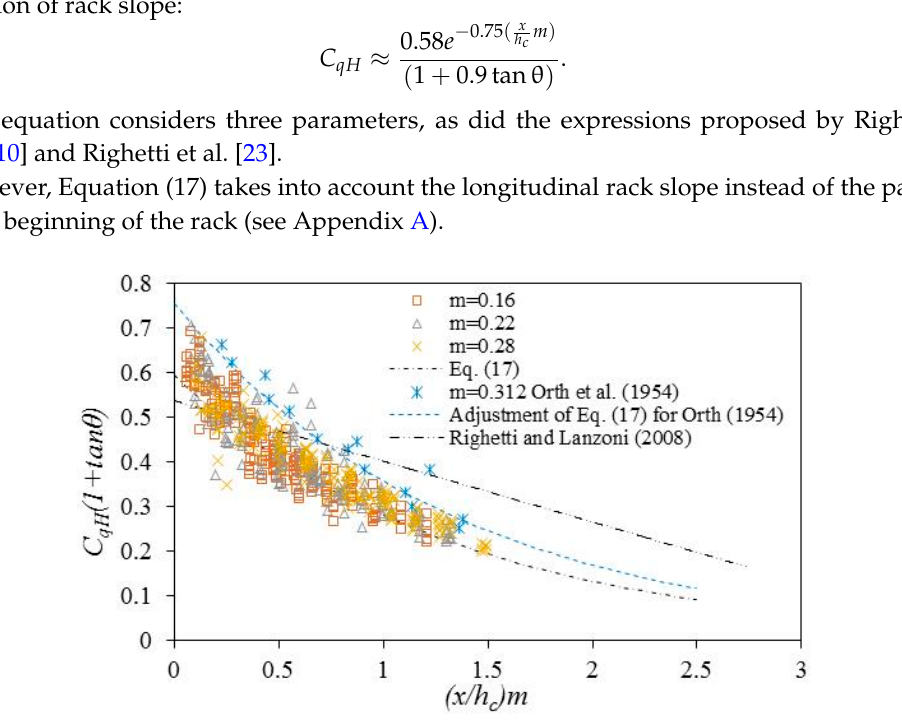
Figure 14. Discharge coefficient, C qH , calculated from Equation (1) for void ratios, m = 0.16, 0.22 and 0.28, and slopes from horizontal to 33%. Exponential adjustment for T ‐ shaped bars and for measurements by Orth et al. [1]. Discharge coefficient adjustment from Righetti and Lanzoni [10].